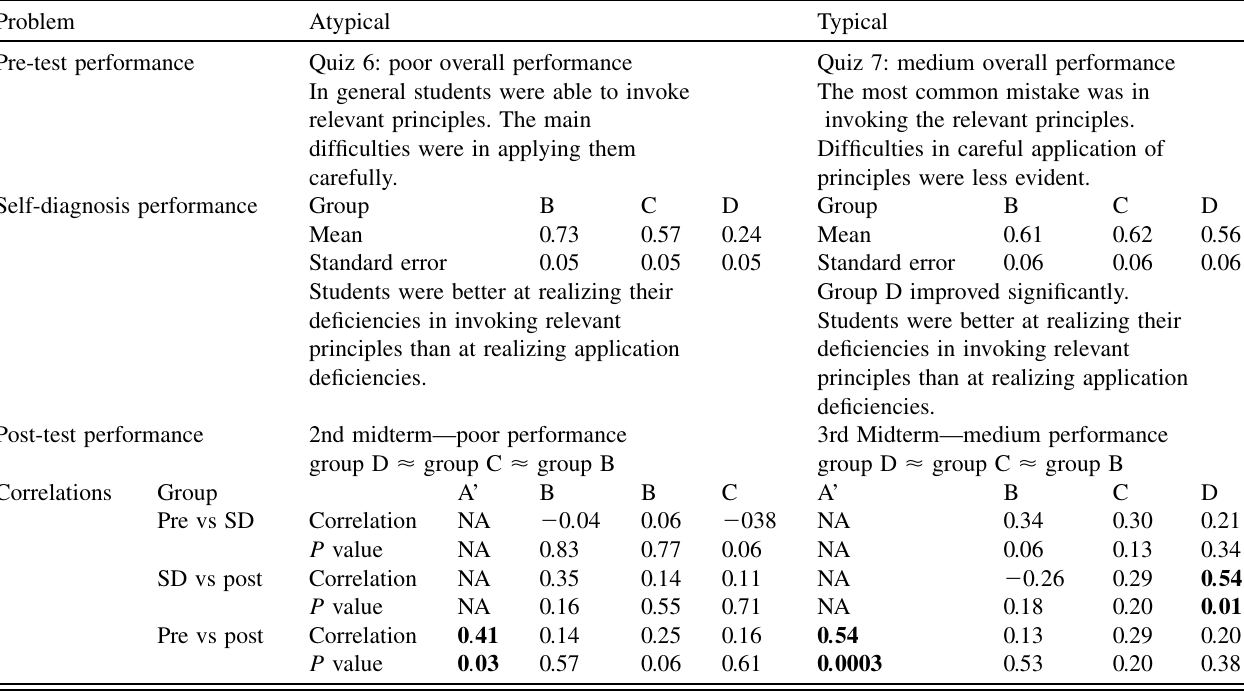
TABLE X. Comparison of students’ performance in a self-diagnosis task and subsequent post (transfer) problem in the context of an atypical and a typical problem situations. SD refers to the students’ self-diagnosis. NA means there is no applicable correlation for the item in